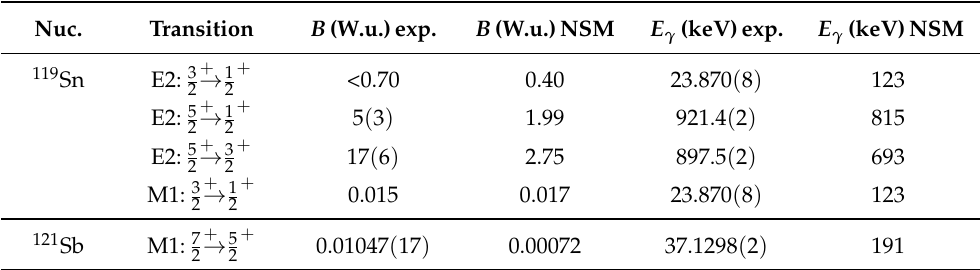
Table 4. Reduced transition probabilities and energies for electromagnetic transitions between the lowest few states in 119 Sn and 121 Sb. The effective charges and g-factors used were e p = 1.5e, e n = 0.5e, g ef f = g free l